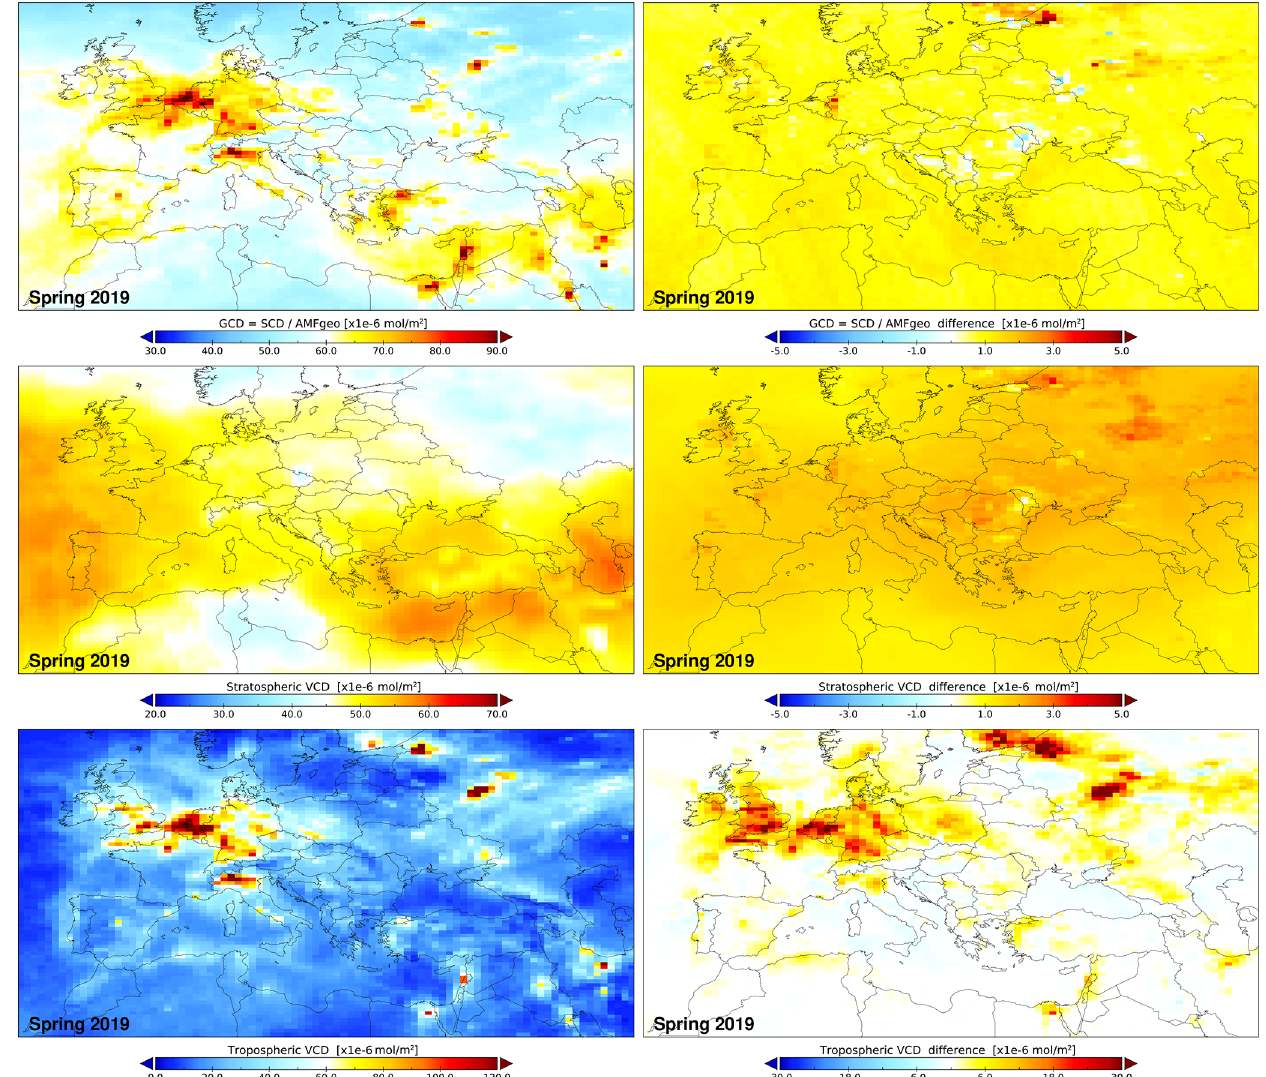
Figure 5. Maps of gridded data averaged over the spring 2019 VCD period (cf. Table 1) of all ground pixels with valid retrieval: the NO 2 GCD (top row), stratospheric VCD (middle row) and tropospheric VCD (bottom row) values of the v2.1 data (left column) and the “DDS minus OFFL” difference (right column), all in µmolm − 2 . The depicted area is longitude [ − 15 to + 55 ◦ ], latitude [ + 27 . 5 to + 62 . 5 ◦